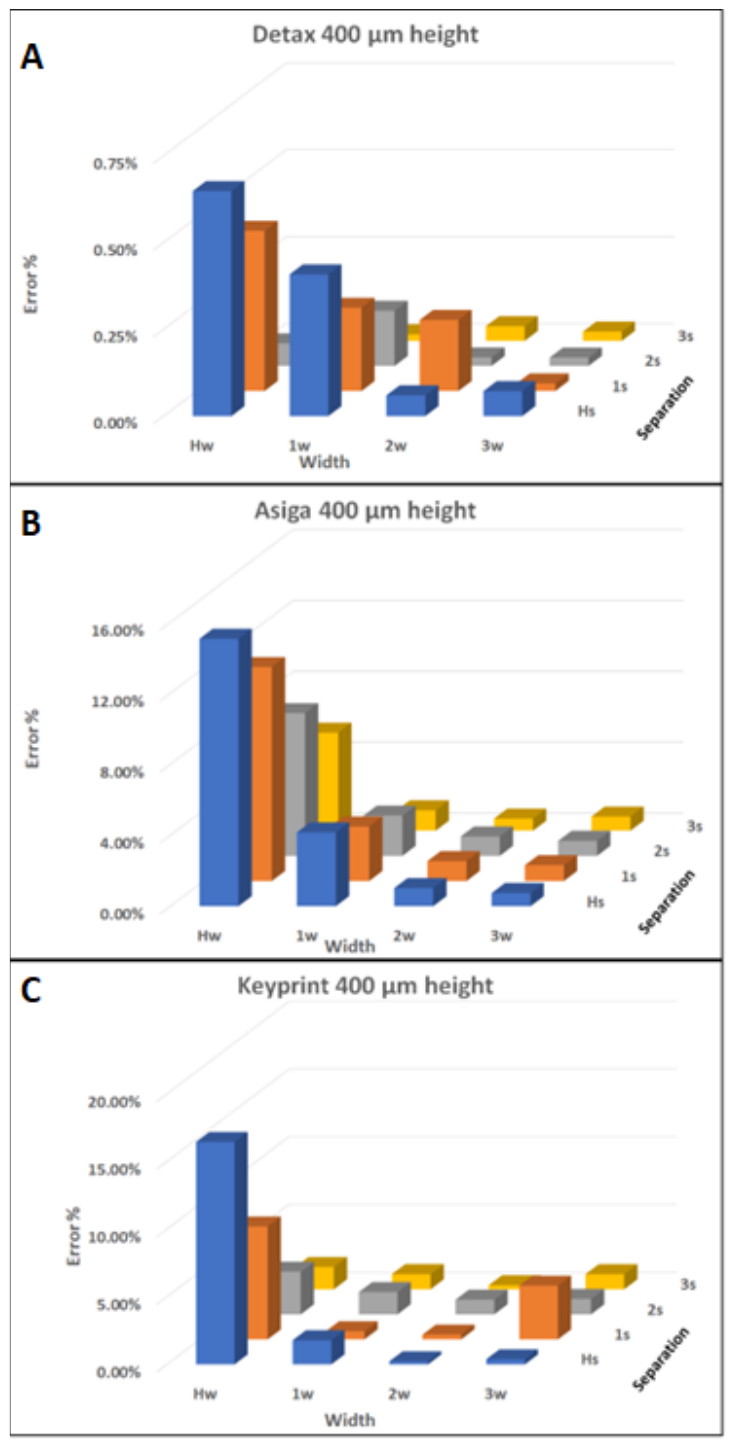
Figure 7. ( A ) Graphic from the error obtained printing the Detax part of 400 µ m height. ( B ) Graphic from the error obtained printing the Asiga part of 400 µ m height. ( C ) Graphic from the error obtained printing the Keyprint part of 400 µ m height. In all ( A – C ), the X-axis corresponds to the width of the feature, going from the half of the height in the left to three times the height in the right. The Y-axis instead corresponds to the separation between the features, going from the half of the width in the front to three times the width in the back. The Z-axis represents the error calculated in the height of the features in